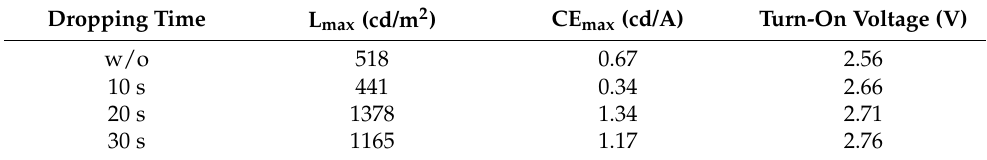
Figure 3. Performance of PeLEDs with ethyl acetate dropped at different times ( a ) current density vs. voltage curve, ( b ) luminance vs. voltage curve, ( c ) current efficiency vs. voltage curve, and ( d ) electroluminescence spectra. Table 1. Summary of the device parameters of PeLEDs with different dropping times of ethyl acetate.